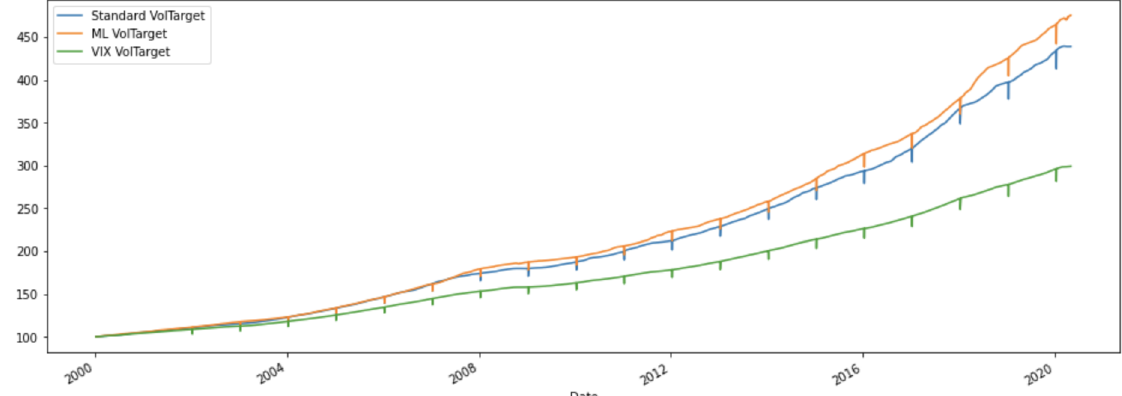
Figure 18. Comparison of the averaged return from the VolTarget strategies for a 20 year time horizon using the VIX index, LSTM-GARCH volatility, and realized volatility with the target set to 13% (source: authors’